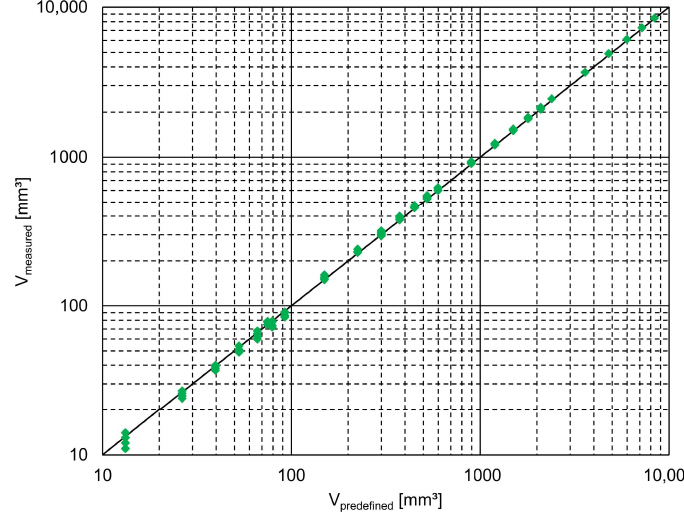
Figure 5. Comparison between photogrammetrically determined volumes against predefined volumes using the three different test areas.